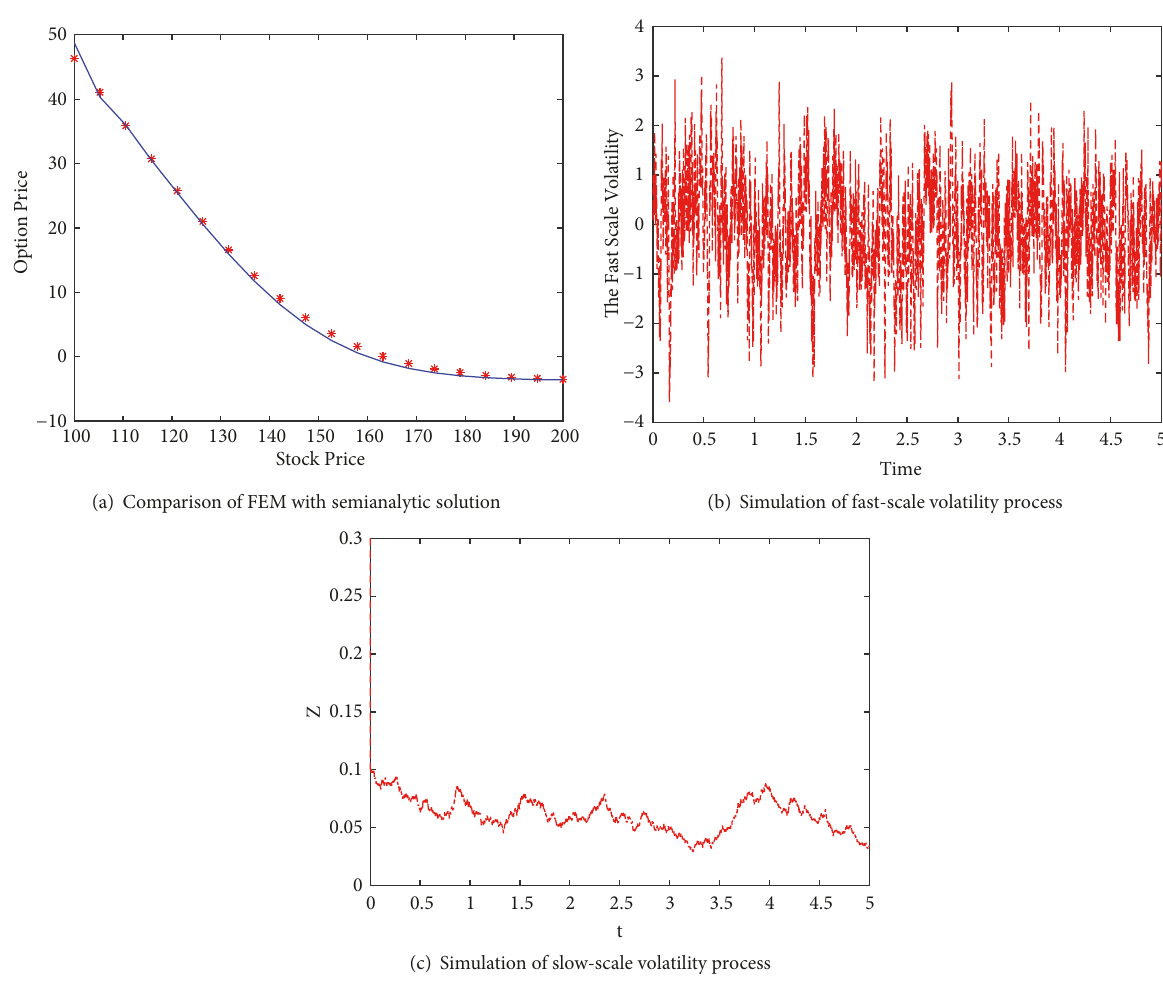
Figure 3: Simulation of volatility process.